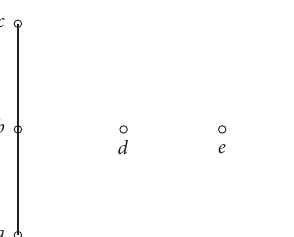
Figure 5: Figure of S for Example 5.